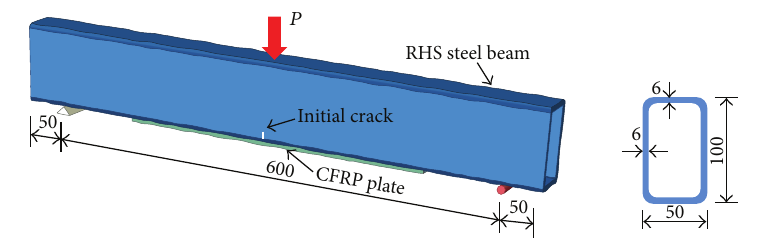
Figure 1: Geometry configurations.